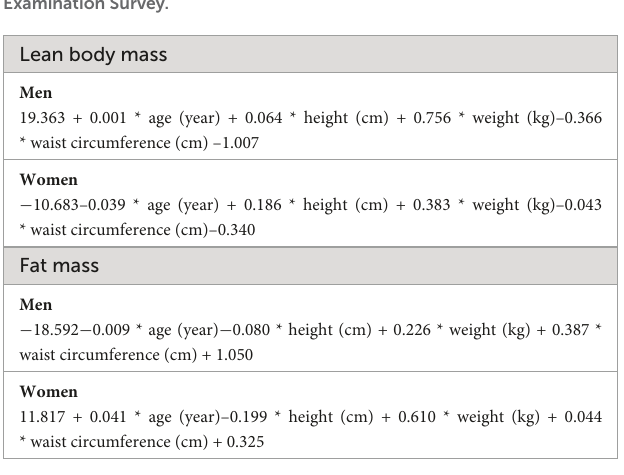
TABLE 1 Anthropometric prediction equations for lean body mass (LBM) and fat mass (FM) developed from the National Health and Nutrition Examination Survey.